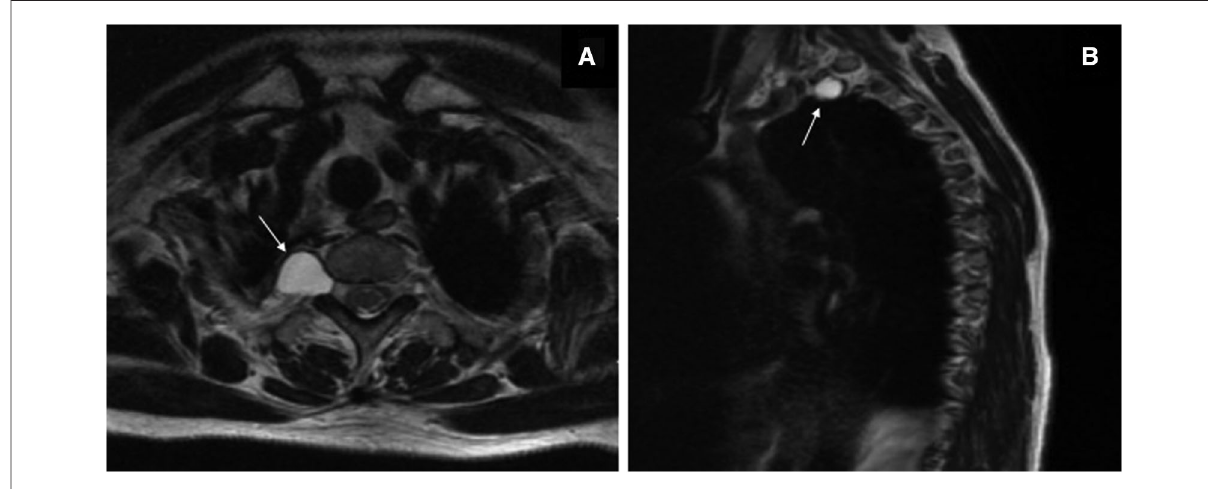
FIGURE 1 T2-weighted magnetic resonance imaging before the thoracoscopic surgery. Axial image ( A ) and sagittal image ( B ) showing a hyperintense oval lesion, with signal intensity similar to fl uid, originating in the posterior mediastinum, protruding into the apical thorax at the level of the right T1 – T2 intervertebral foramen ( white arrows